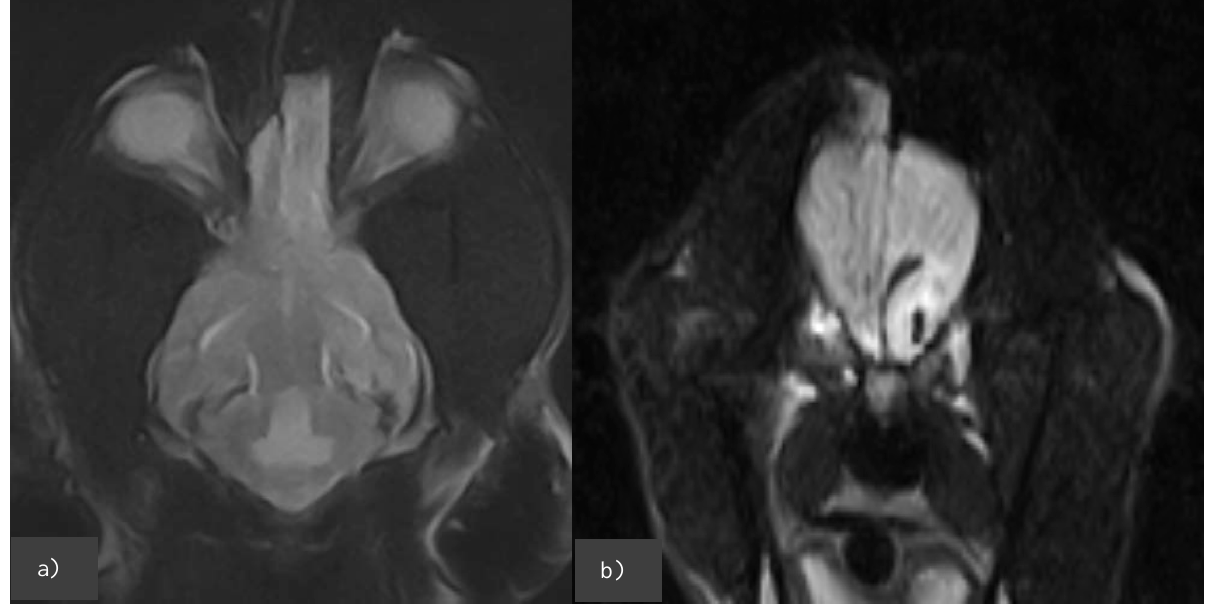
Fig. 4. Magnetic resonance imaging of the dog with post-traumatic changes in the brain (14 days after injury) Note : a, b – coronary, and axial sections in T2 and FLAIR modes show a slight inflammatory process in the left olfactory bulb on the brain parenchyma (MRI